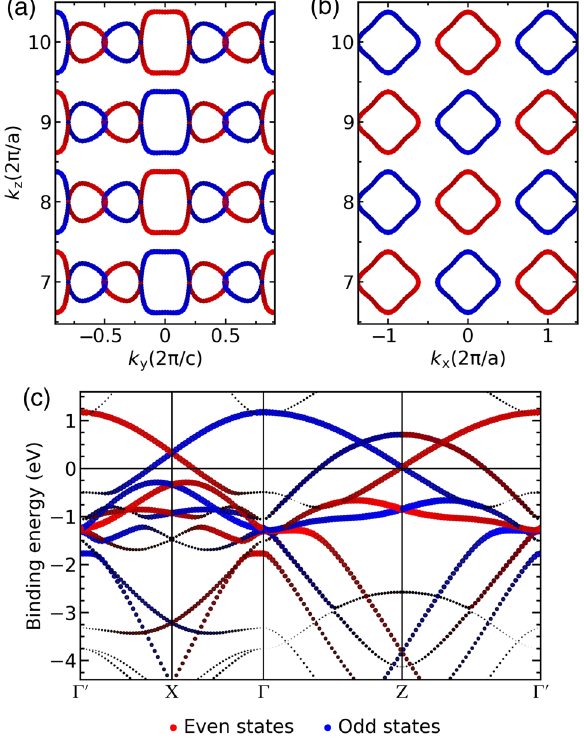
¼ 0 . 4 eV) calculations projected on FIG. 5. GGA þ U ( U eff the even (red) and odd (blue) basis sets: (a,b) FS along the planes p 2 and p 3 , respectively, as reported in Fig. 1; (c) bands along the Γ 0 - X - Γ - Z - Γ 0 directions (majority spin only). The spot size is proportional to the projection on even and odd basis sets; the color is obtained from the percentage representation of colors in the RGB format proportional to projection on and even (odd) basis set for the red (blue) component. The two basis sets complement each